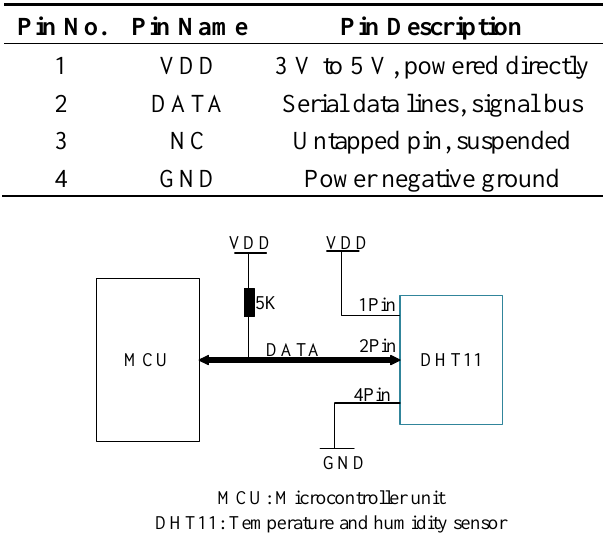
Table 3. The pins description of DHT11 [22].